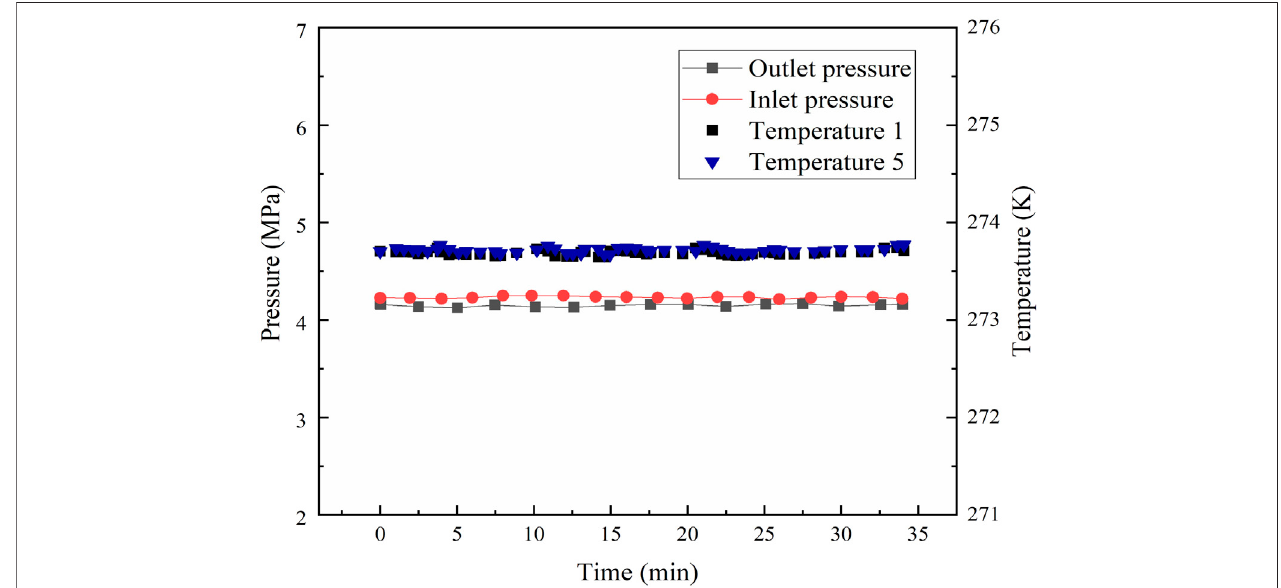
FIGURE 4 | The variations in inlet/outlet pressure and temperature during permeability